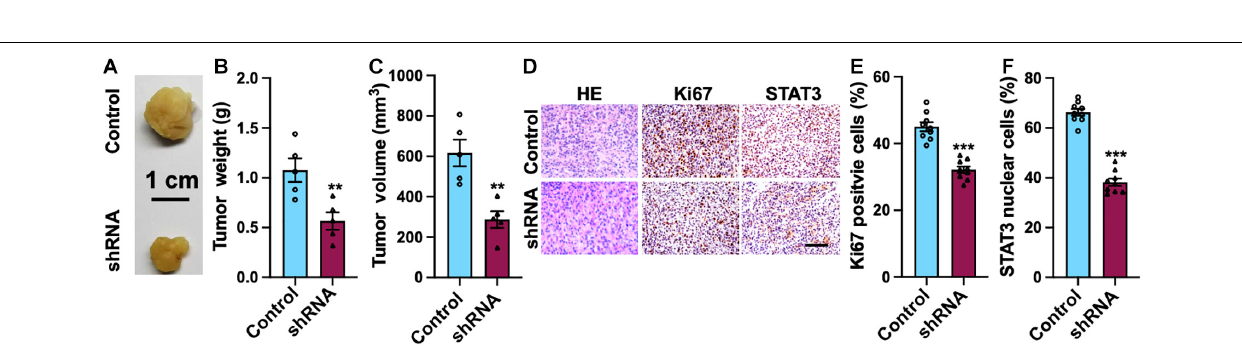
FIGURE 8 | SH2B3 is essential for mouse xenograft tumors to grow in vivo . (A) Representative images of tumors derived from U87 control or SH2B3 shRNA cells. Scale bar = 1 cm. (B) Weight of indicated tumors. (C) The volume of indicated tumors. (D) Immunohistochemistry staining with tumors derived from U87 control or SH2B3 shRNA cells using indicated antibodies, and representative images were shown. Scale bar = 100 µ m. (E,F) Quantification data for panel (D) . *, **, and *** indicate p < 0.05, p < 0.01, and p < 0.0001, respectively.